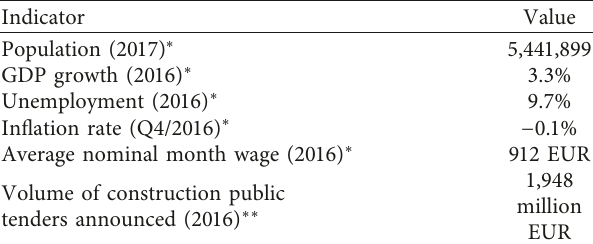
Table 1: Characteristics of study